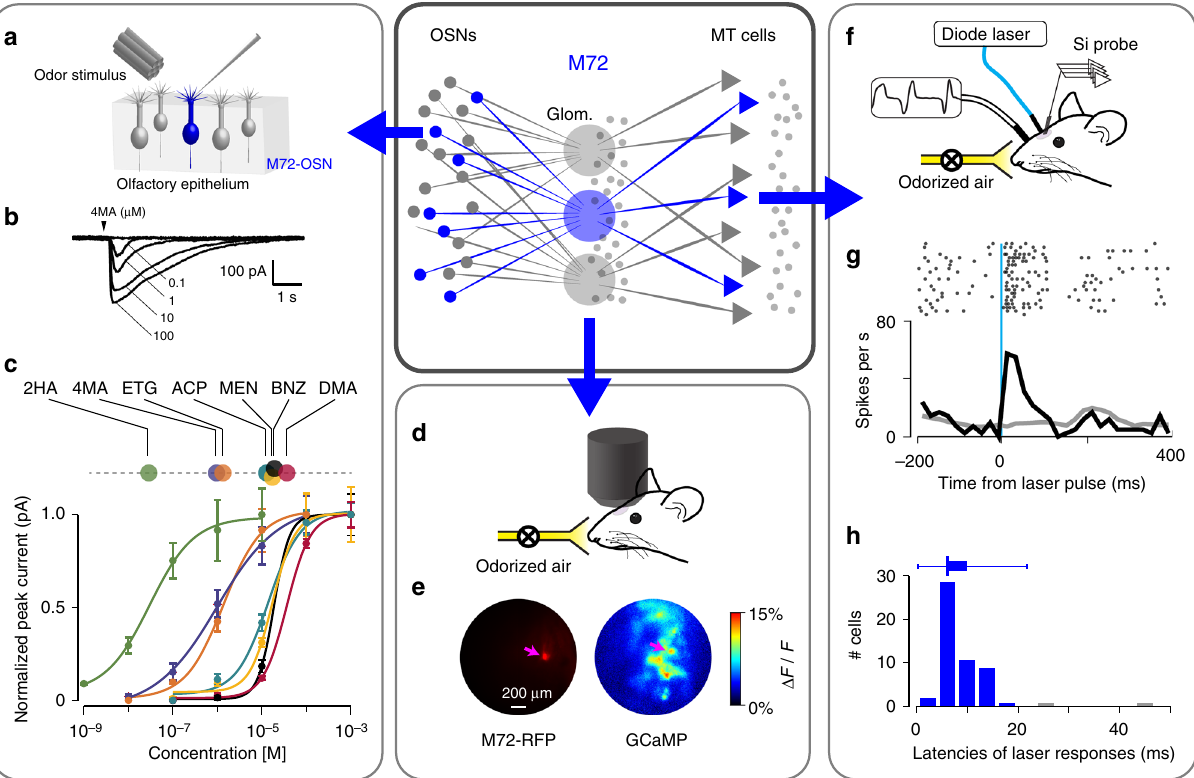
Fig. 1 Characterizing information in a single channel of the mouse olfactory bulb. Central insert: schematic of the olfactory bulb network. Axons from OSNs expressing the same receptor gene converge to form glomeruli, each providing the sole excitatory input to a few MT cells. Odor signals are subject to signi fi cant modi fi cation by a network of inhibitory neurons (small gray dots). a Experimental setup for characterizing OSN responses to odor. Patch clamp recordings are made from dendrites of fl uorescently labeled OSNs expressing the M72 receptor. b Example traces of OSN odor responses. c Normalized dose – response curves for seven M72 ligands fi tted by the Hill equation ( n = 5 – 7 OSNs per odorant; mean ± SEM); EC 50 values indicated in linear plot above. Odors used: 2-hydroxyacetophenone (2HA); ethyl tiglate (ETG); 4-methyl acetophenone (4MA); acetophenone (ACP); menthone (MEN); benzaldehyde (BNZ); and 2,4-dimethyl acetophenone (DMA). EC 50 values are given in Supplementary Table 1. d Experimental setup for imaging. An awake, head- fi xed mouse (OMP-GCaMP + M72-RFP) with implanted window above the OB is positioned under the microscope. e Left: image of a RFP M72 glomerulus. Right: Ca 2 + image of glomerular response to an odor (2HA). M72 glomerulus here and further is marked by magenta arrow. f Experimental setup for in vivo recording of odor responses from MT cells connected to the M72 glomerulus. A head- fi xed mouse is positioned in front of the odor port. The sniff signal is recorded by a pressure sensor via a cannula implanted in the nasal cavity. Brief pulses of blue light are delivered to the ChR2-expressing M72 glomerulus through an optical fi ber positioned above the glomerulus. MT cell responses are recorded with a Si-probe inserted nearby. g Example of MT cell excitation following laser stimulation of the M72 glomerulus. Raster plot (upper panel) and PSTH (lower panel) around the onset of a 1 ms pulse showing the stimulus response (black line) and the baseline activity (gray line). h Distribution of response latencies to a 1 ms, 5 – 10 mW light pulse. Light-responsive cells with latencies longer than 20 ms (colored gray in the histogram) were excluded from the